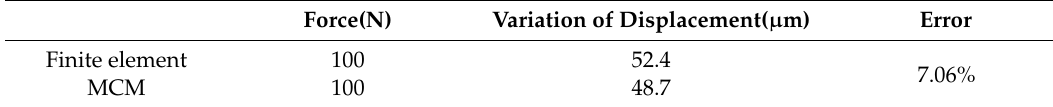
Figure 4. Displacement in the Y-direction. Table 2. Comparison of finite element analysis method and MCM